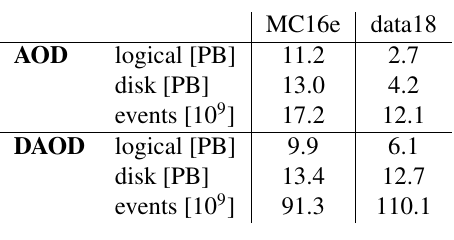
Table 1: Sums of dataset samples sizes for di ff erent production campaigns in 2018 for data and MC samples, in AOD and DAOD